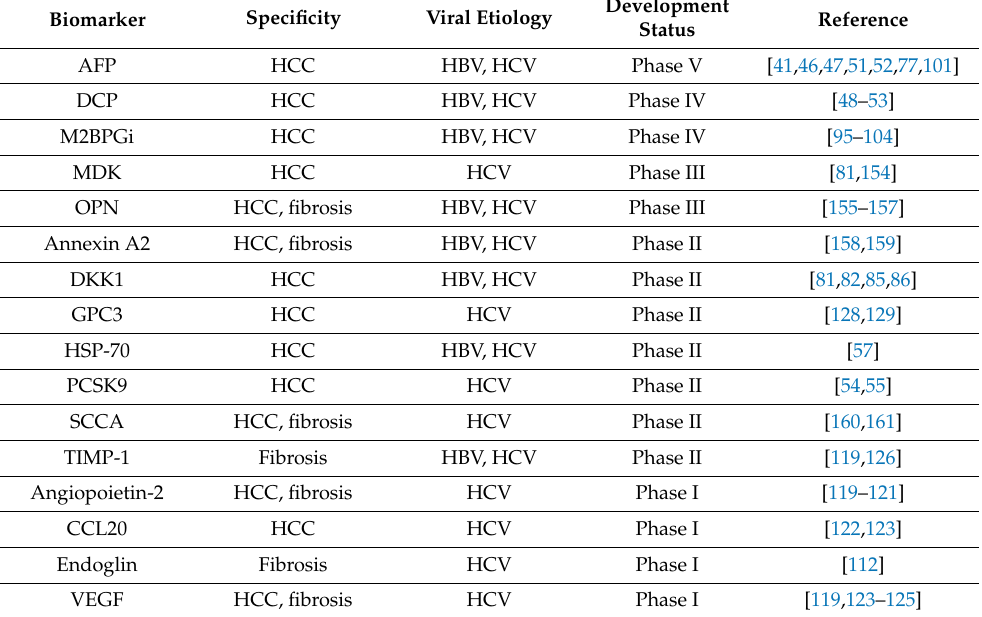
Table 1. Promising minimally invasive biomarker candidates with links to virus-induced signaling (HBV, HCV) and predictive of liver fibrosis and HCC. Biomarker research is categorized into phases I–V [153]: phase V (evaluates the effect of the biomarker screening in the burden of the disease in the population), phase IV (prospective evaluation of the biomarker to assess its clinical performance), phase III (testing in patients before their diagnosis to determine the performance of the biomarker in detecting pre-clinical disease), phase II (testing in patients at high risk to determine the performance of the biomarker in distinguishing between patients with and without the disease), phase I (discovery of new biomarkers by investigating gene expression and protein levels in pathological tissue and patient